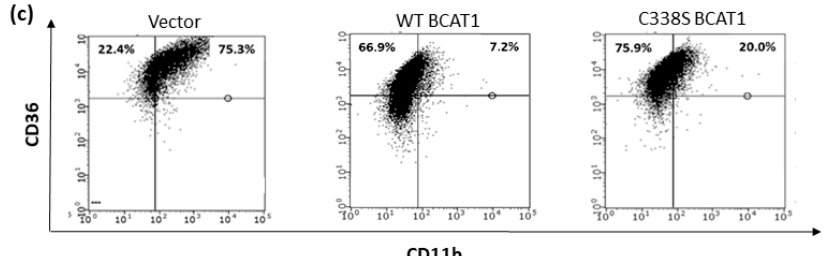
Figure 8. Differential myeloid cell marker expression (CD11b and/CD36) and intracellular ROS following treatment with PMA. U937 monocyte to macrophage differentiation was induced by incubation with ± 10 ng/mL PMA for 48 h, to control for BCAT1 metabolic and CXXC motif antioxidant activity cells were supplemented with 20 mM Gabapentin and 10 mM N-acetyl cysteine (NAC), respectively. ( a ) charts displaying CD11b positive cells and ( b ) % CD36 positive cells as measured by flow cytometry. ( c ) Representative flow cytometric bivariate plots displaying % CD36 positive cells (y-axis) and % CD11b positive cells (x-axis) across all cell lines following treatment with PMA. Data presented are mean ± SD. Significant differences were calculated using 2-way ANOVA with Bonferroni post-test where, * p < 0.05, ** p < 0.01 and *** p < 0.001 ( n = 3). See Supplemental Figure S5 for flow cytometric gating strategy.